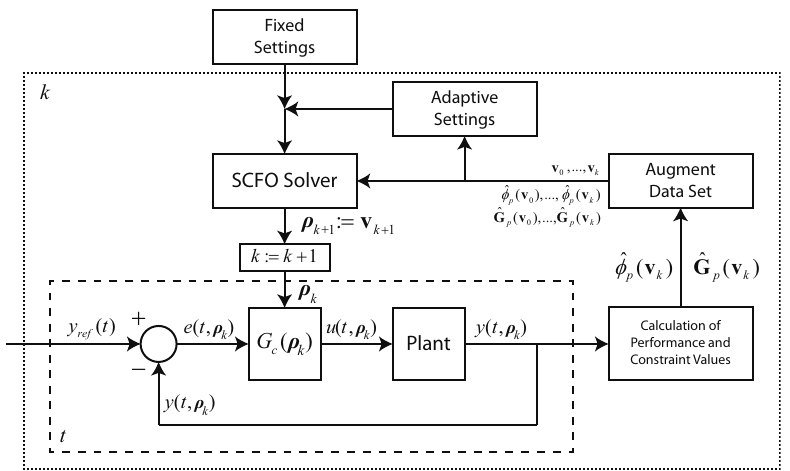
Figure 3. The iterative tuning scheme, where the results obtained after each closed-loop experiment on the plant (denoted by the dashed lines) are sent to the RTO loop (denoted by the dotted box), which then appends these data to previous data and uses the full data set to prompt the SCFO solver, as well as to update any data-driven adaptive settings (we refer the reader to Table 1 for which settings are fixed and which are